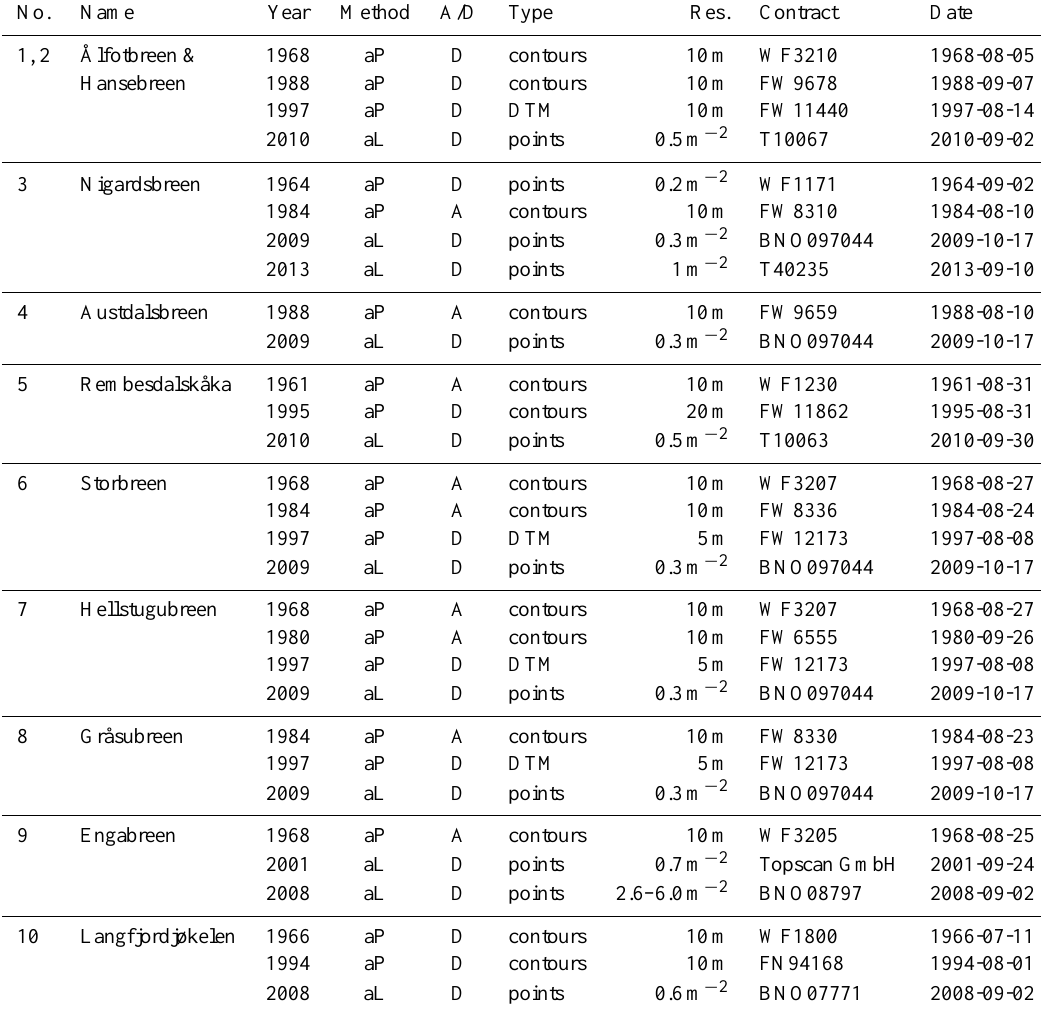
Table 2. Geodetic surveys of the 10 glaciers used in this study. Under method, a refers to airborne, P to photogrammetry, and L to laser scanning. Under A/D, A refers to analogue constructed, later digitised, and D to digital constructed. Res. refers to resolution, contour interval on glacier for contours, resolution of DTM where regular grids were constructed, pointsm − 2 for others. Contract refers to the contract number for aerial photos or for scanning reports. BNO is Blom and T is